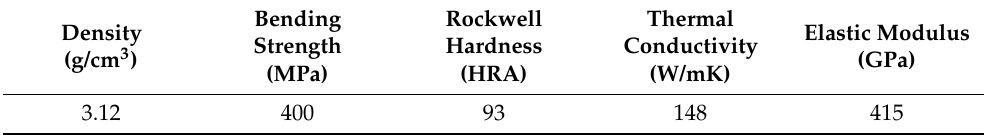
Table 1. Parameters of experimental